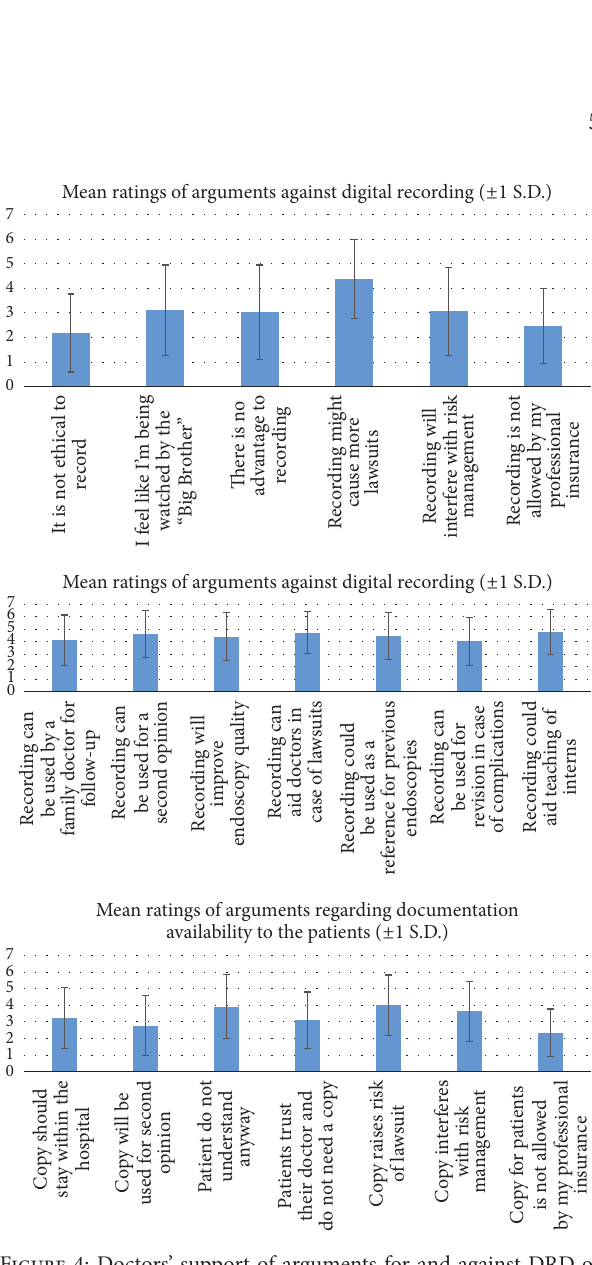
Figure 4: Doctors’ support of arguments for and against DRD of endoscopic procedures, and regarding documentation availability to the